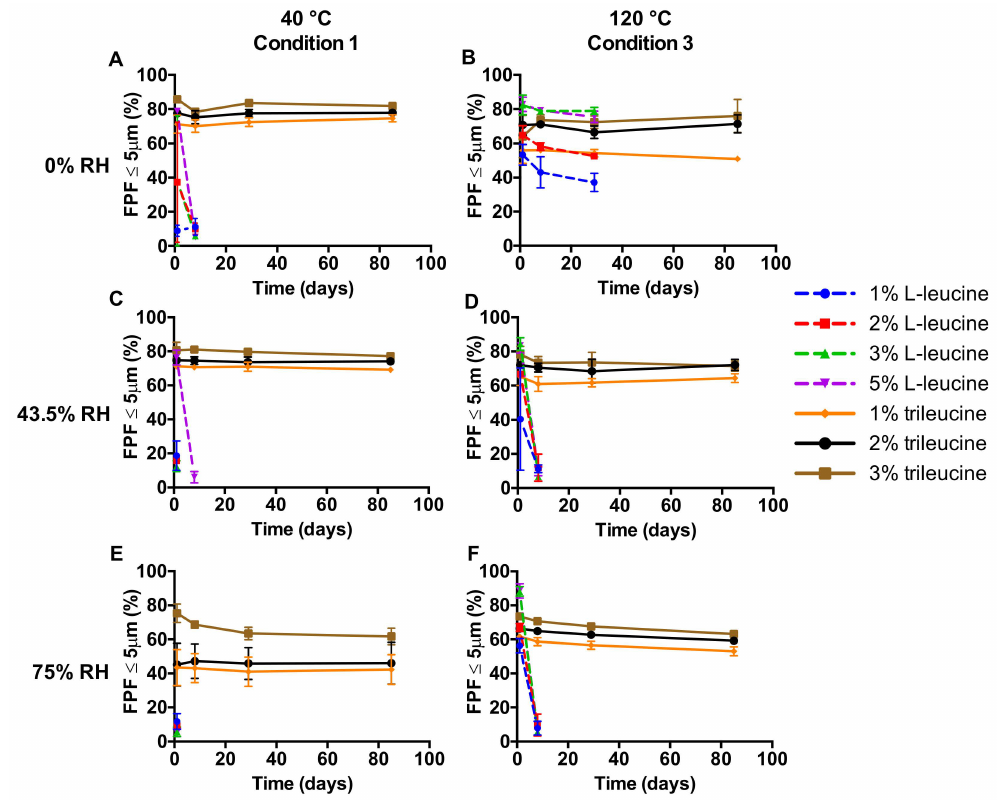
Figure 3. Fine particle fractions (FPFs) over time of isoniazid formulations dispersed from the Twincer ®